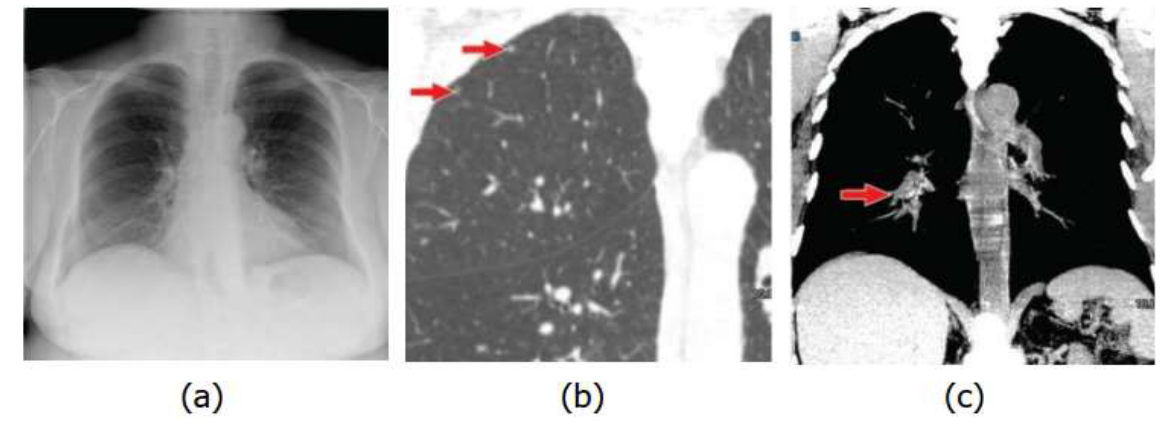
Figure 2. X-rays shows no nodule ( a ), CT scan images identify the lung cancer nodules ( b , c ).